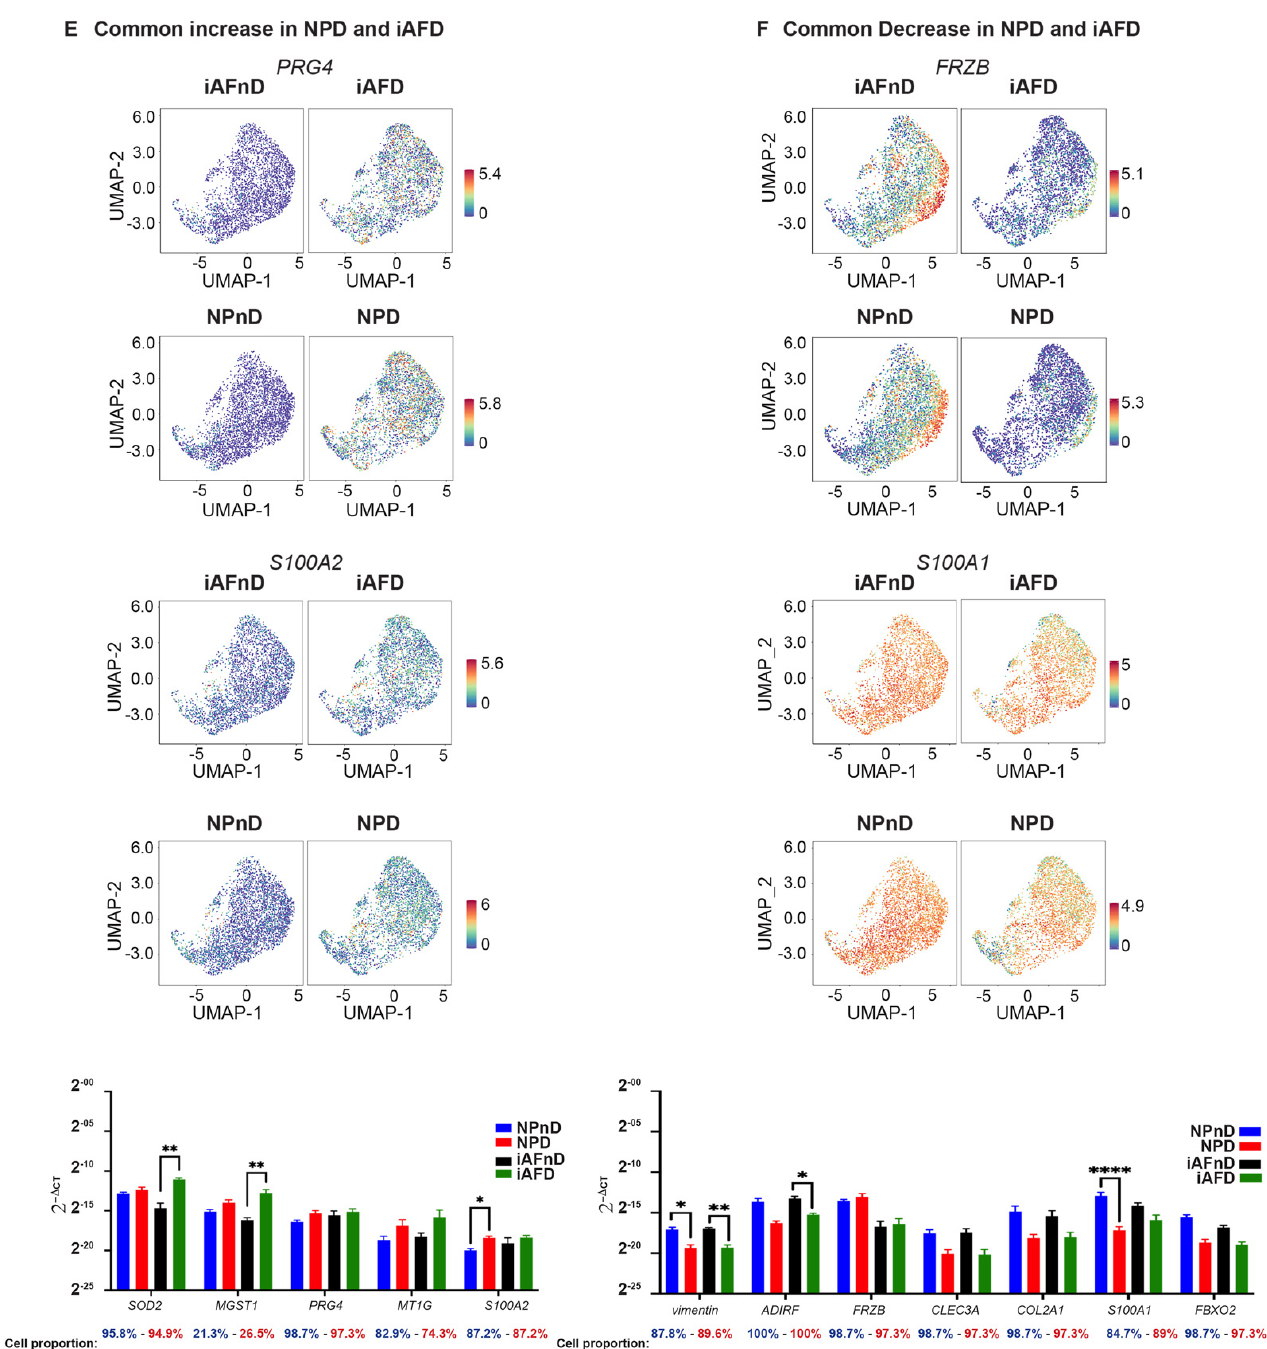
Figure 6. RT-PCR validation of DEGs identified from transcriptome analysis. Representative UMAPs and graphs highlighting the gene expression differences of MSMP, C2orf40, SLPI and EPYC between NPnD and iAFnD in ( A ); SYF2, MT1F, FGFBP2, TAF1D and EPYC between NPD and iAFD in ( B ). RT-PCR validation of IVD degeneration selected DEGs in the transcriptome data of CHI3L2, PLA2G2A, TNRSF11B and FGFBP2 showing an increase or MT-ND2, MT-CYB, CTGF and TAF1D showing a decrease in iAFD ( C ) when compared to iAFnD cells from discs of the same individual. mRNA expression of MT2A, UPP1, HMGA1 and TAF1D (increase) and CAPS, SLPI and SPTSSB (decrease) in NPD compared with NPnD ( D ). Validation of common degeneration markers by RT-qPCR showing an increase or a decrease with degeneration NPD ( E ) and AFD ( F ). The values were calculated using the 2 −∆∆ Ct method: * p < 0.05, ** p < 0.01 and **** p < 0.0001.